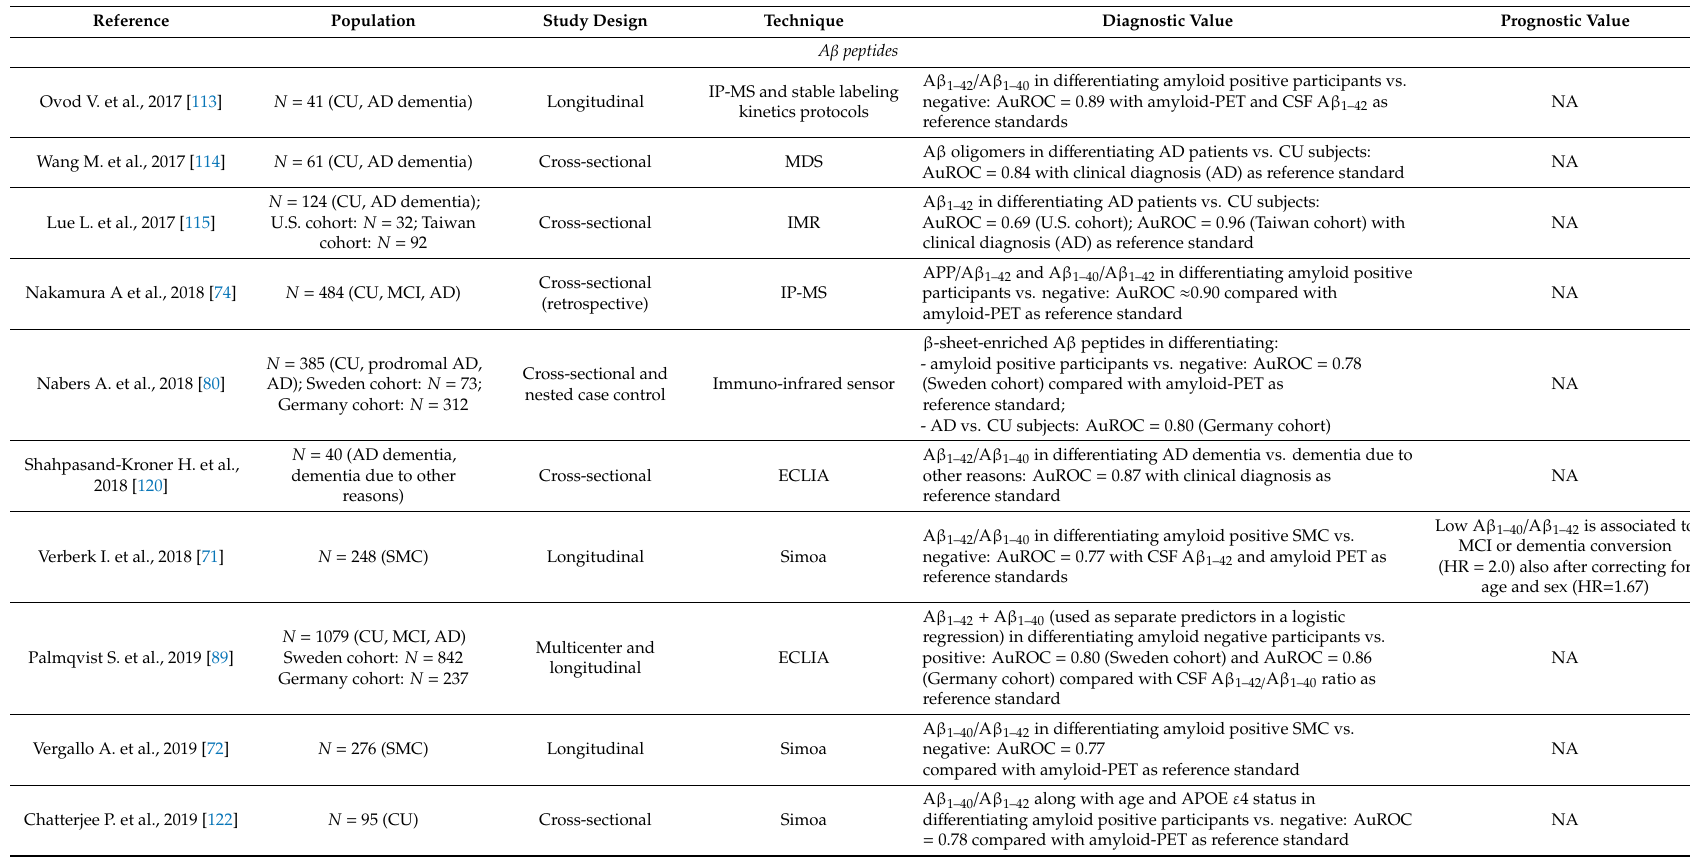
Table 3. Diagnostic and prognostic role of blood A β peptides, p-tau, t-tau, and NFL proteins measured with ultrasensitive techniques in